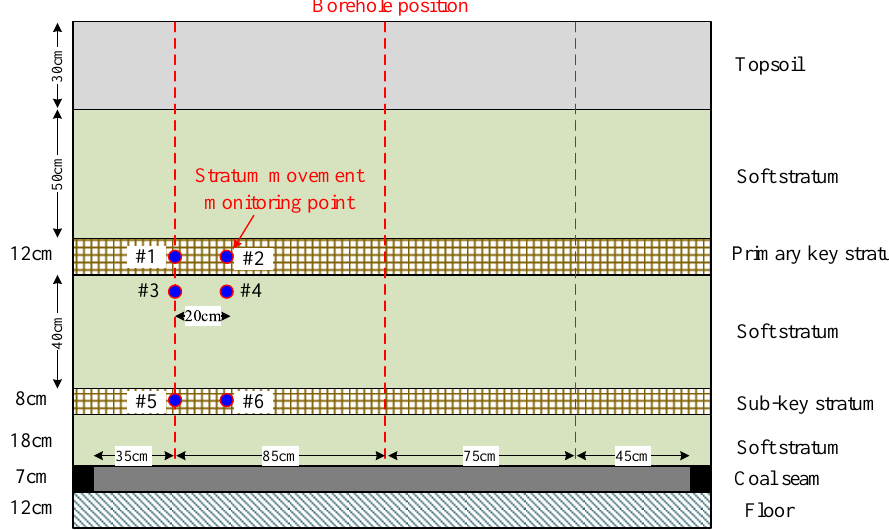
Figure 4. Configuration of the physical model and the monitoring positions.